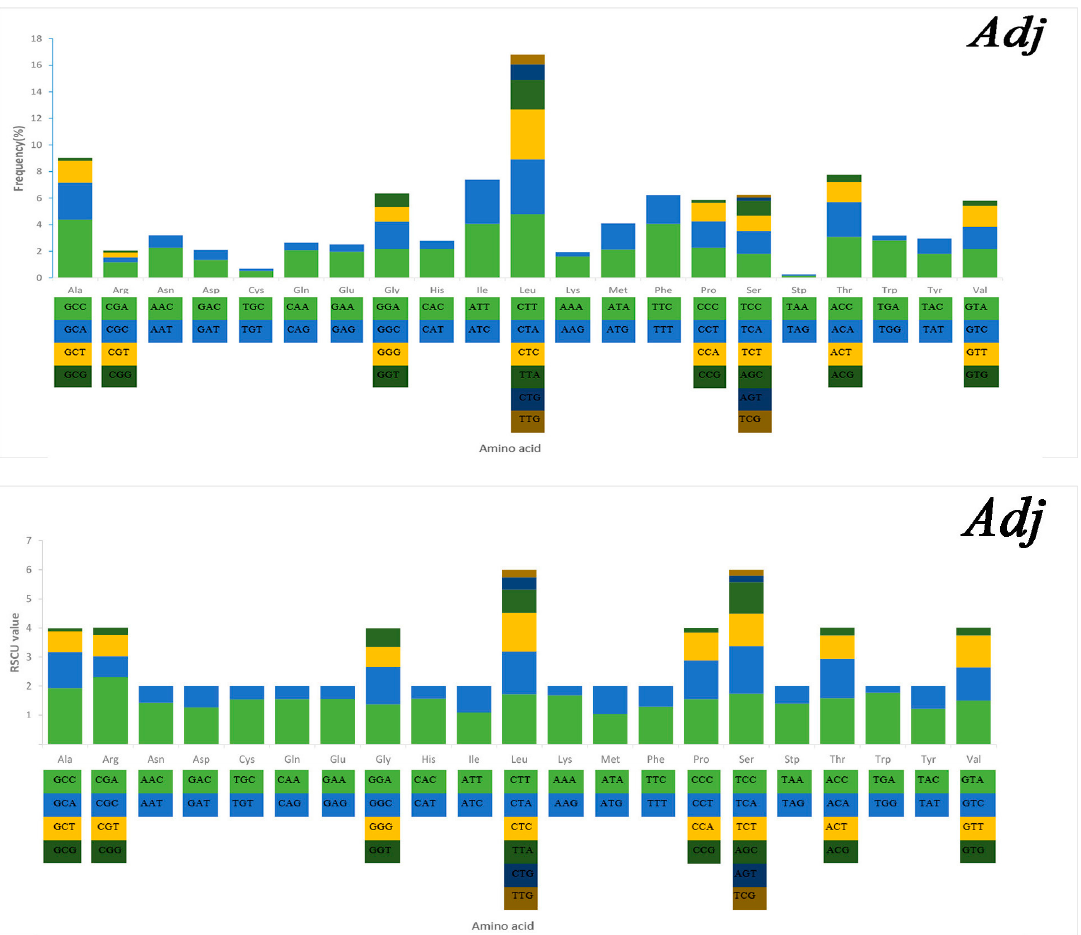
Figure 5. Codon frequency and RSCU (relative synonymous codon usage) in the mitochondrial genomes of Alectis indicus ( Ain ), Decapterus tabl ( Dt ), and Alepes djedaba ( Adj ).